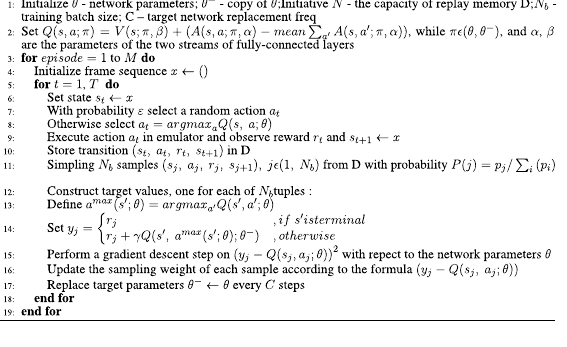
Algorithm 1. Prioritized